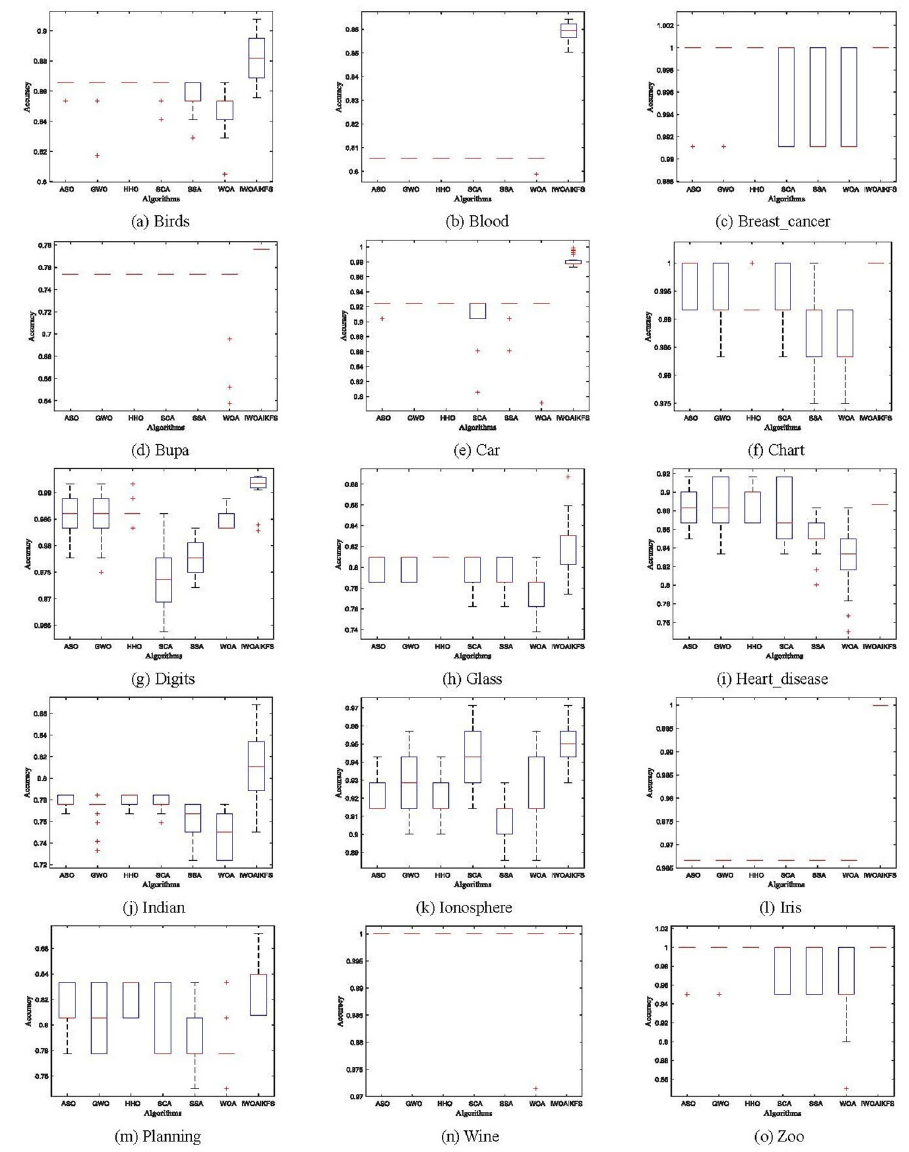
(m) Planning, (n) Wine, (o)